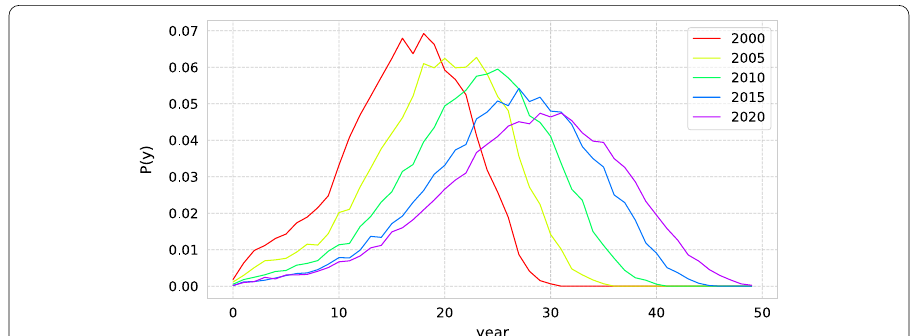
Fig. 10 Probability of gap year between SB and PR. Length of sleep duration for SB and PR pairs in the dataset divided into 5-year increments. The mean values are 16.0, 19.3, 22.7, 25.9, and 27.9 years, which is about half of the total length of the